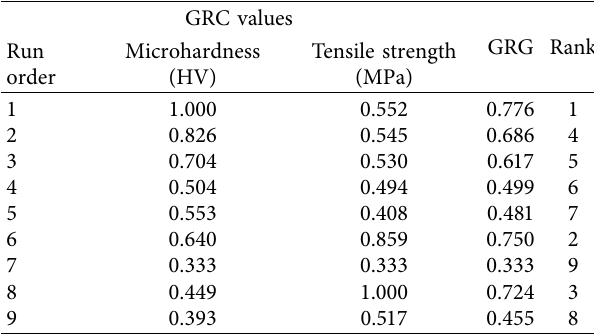
Table 9: Grey relation analysis